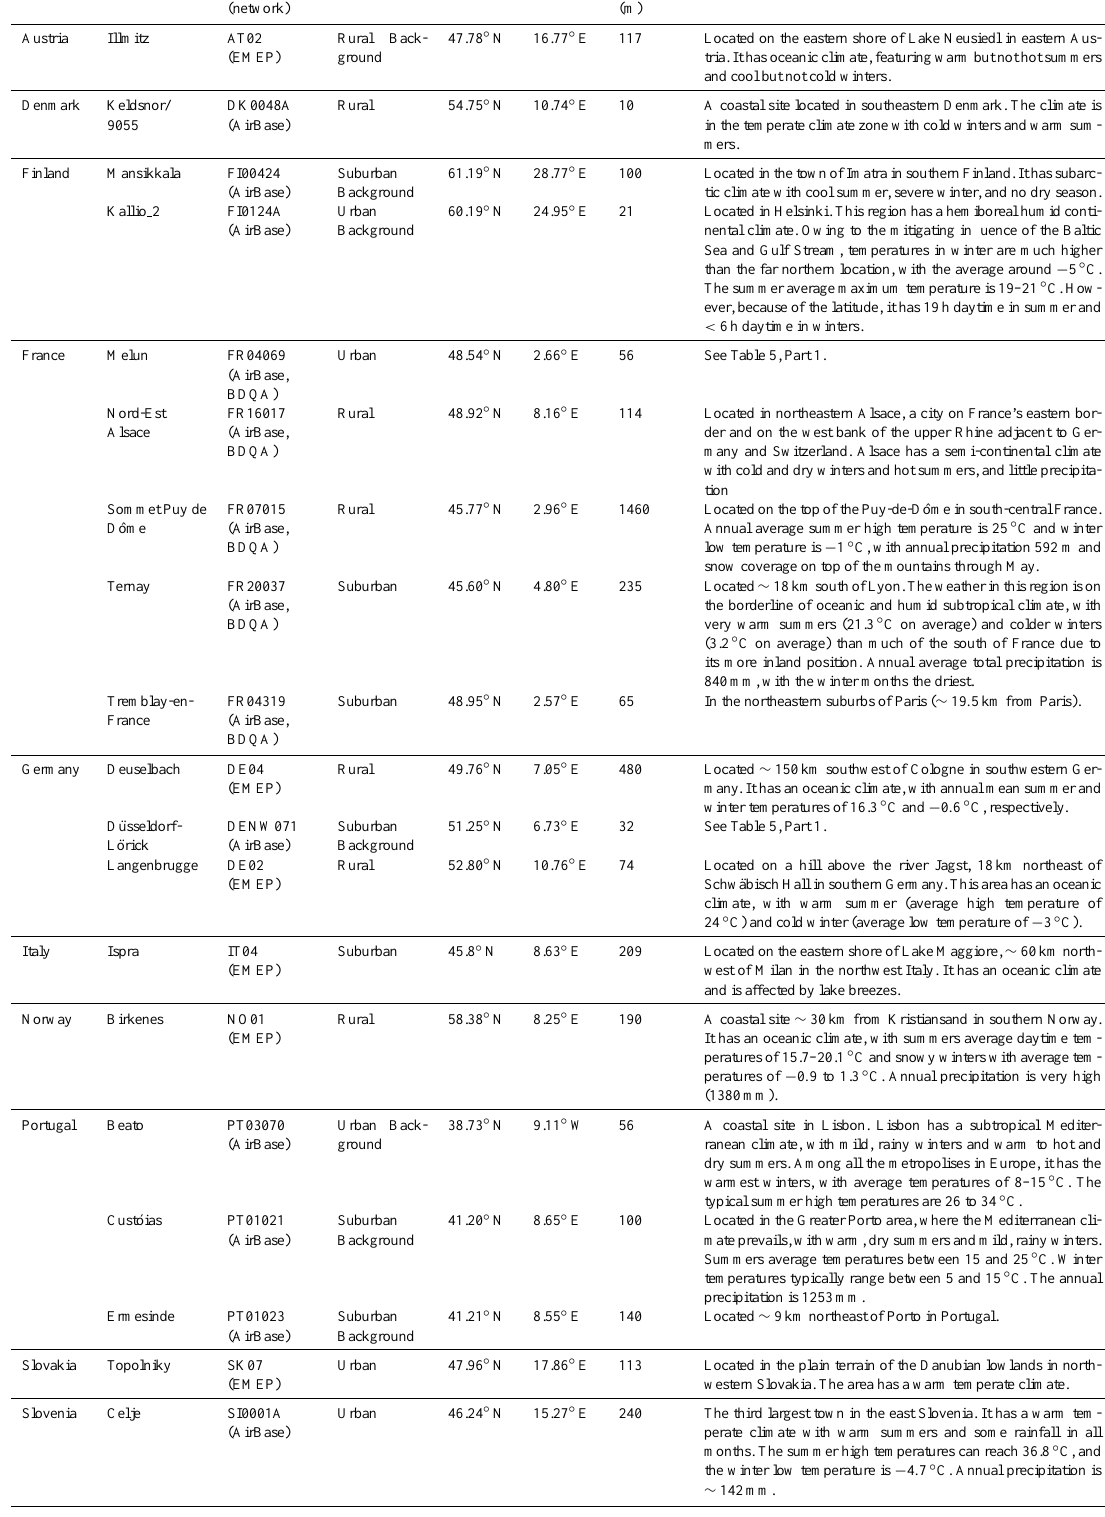
Table 3. Characteristics of sites selected for temporal analysis.